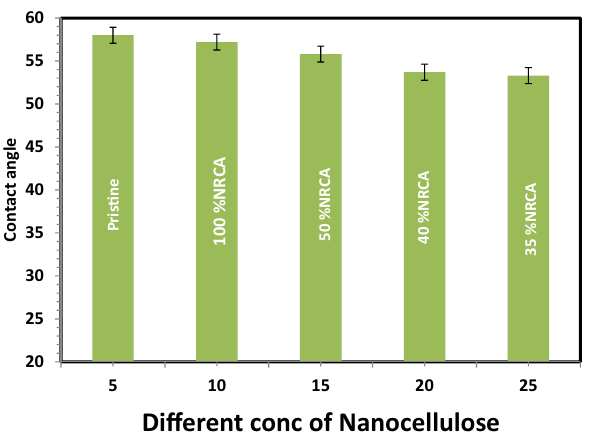
Figure 8. Contact angle of different concenteration nanocellulose membrane versus pristine CA membrane.